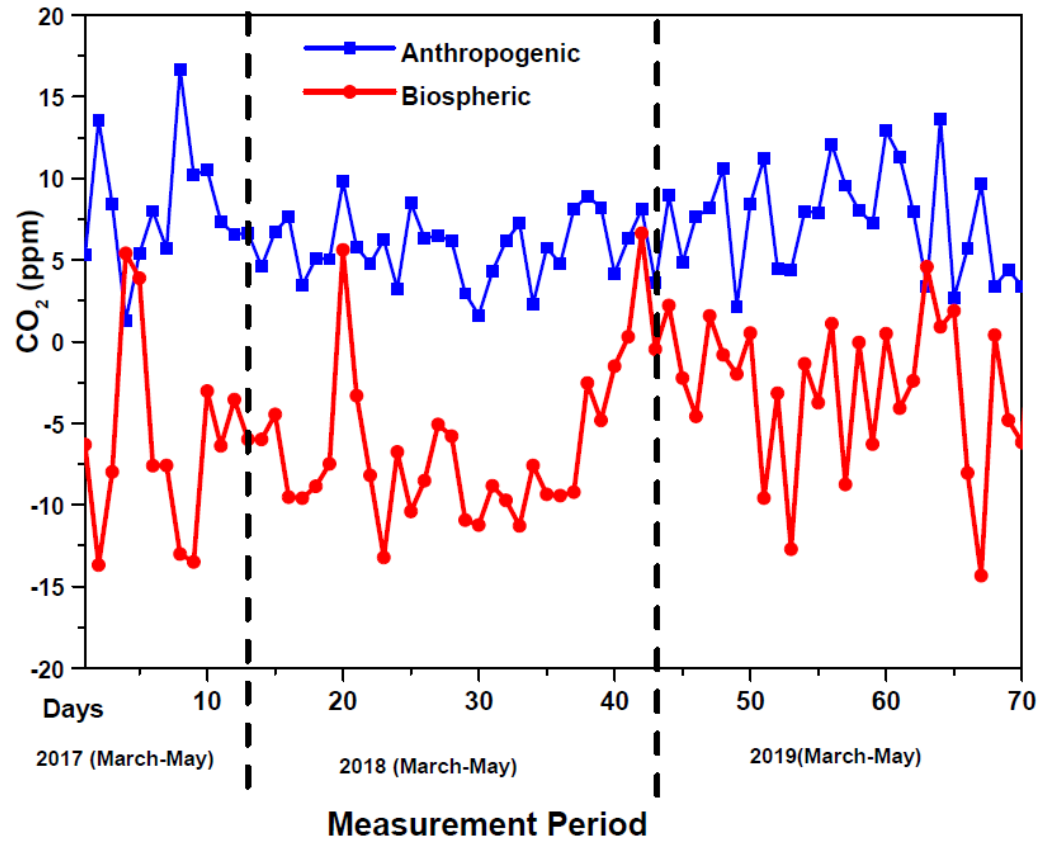
Figure 4. Springtime biogenic and anthropogenic CO 2 . The CO 2 mixing ratios in this plot were estimated using the respective springtime β − 1 values and Equation (5). Table 3. Springtime biogenic and anthropogenic CO 2 (ppm) mixing ratios calculated using the CO tracer technique. The number of days ( n ) in winter 2017, 2018, and 2019 are 13, 31, and 30,